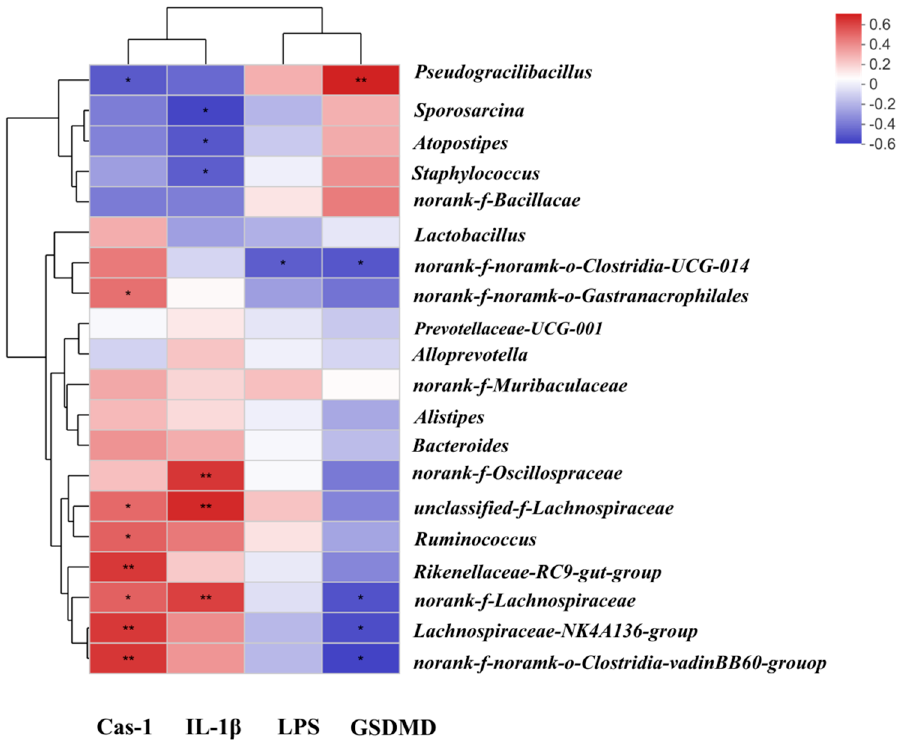
Figure 6. The Spearman’s correlation analysis among gut microbiota, LPS and the levels of Cas-1, GSDMD and IL-1 β . * p < 0.05; ** p < 0.01.